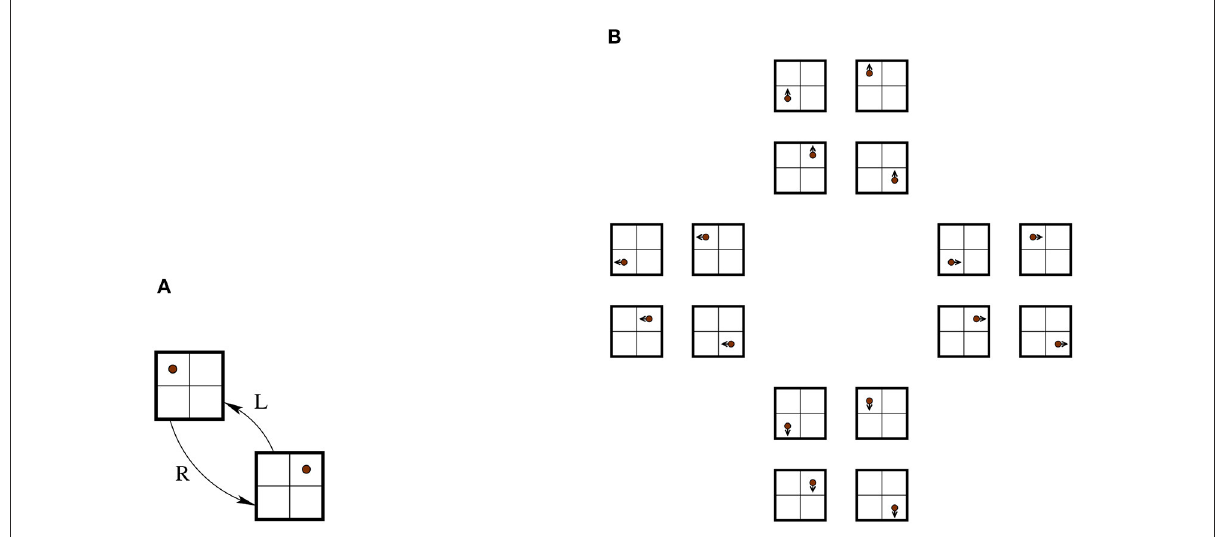
FIGURE4 (A) A two-state automaton results from the realized policy. (B) If there are only two actions (rotate 90 degrees counterclockwise and going straight) then the second automaton has 16 states instead of four as in Figure 3B.